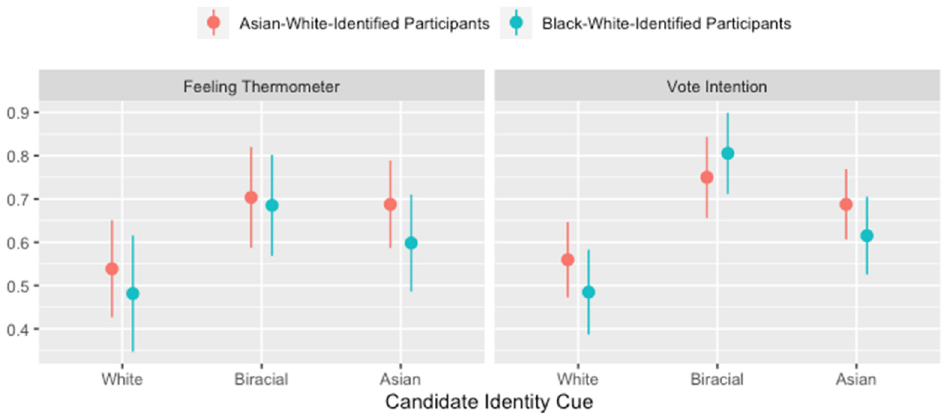
Figure 3. Mean feeling thermometer and vote intention ratings of hypothetical candidates from the Asian and White heritage treatment conditions. Sample includes Asian-White-identified participants (i.e., those who self-identified as Multiracial and used the words “Asian” and “White” to describe their racial identity) and Black-White-identified participants. X -axis denotes different treatment groups based on the identity cued by our hypothetical candidates. Note: error bars denote 95% confidence intervals.